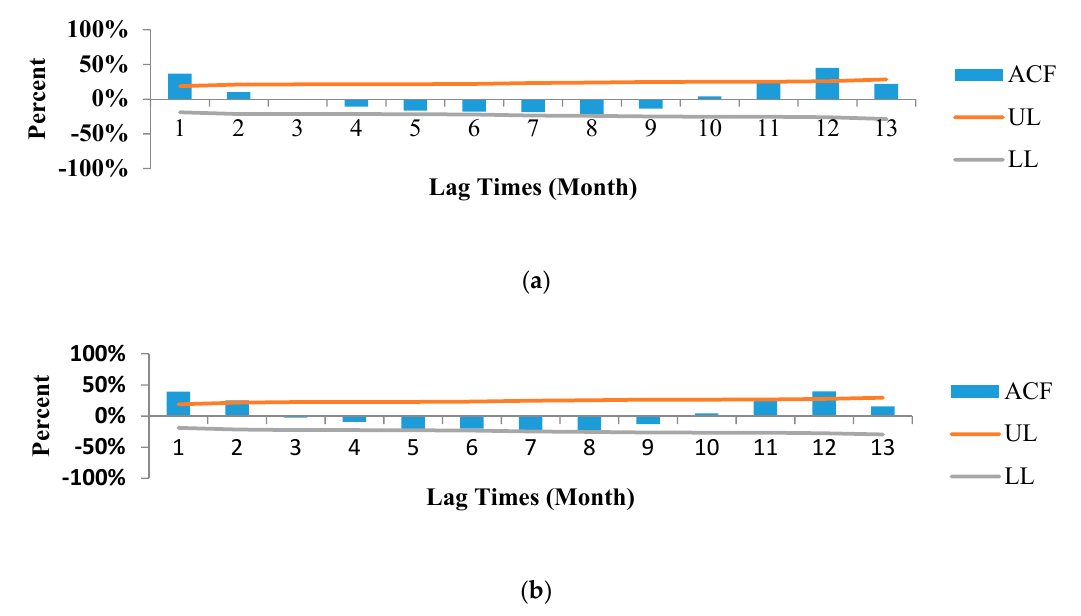
Figure 3. Correlogram of precipitation time series for ( a ) Ercan station; ( b ) Lefko ş a station. UL = Upper Limit; LL = Lower Limit.